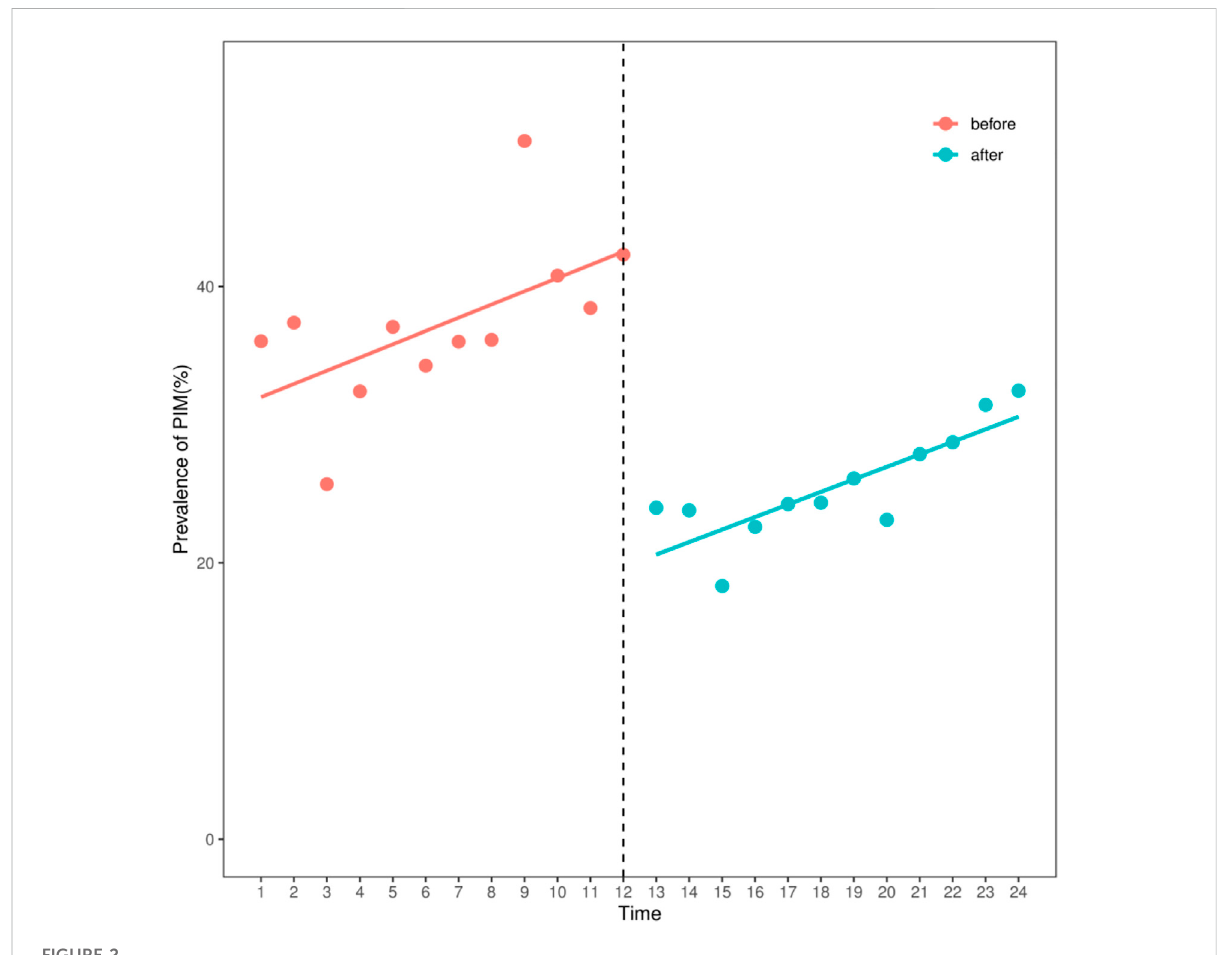
FIGURE 2 The prevalence of PIM use in Chengdu, 2016 –